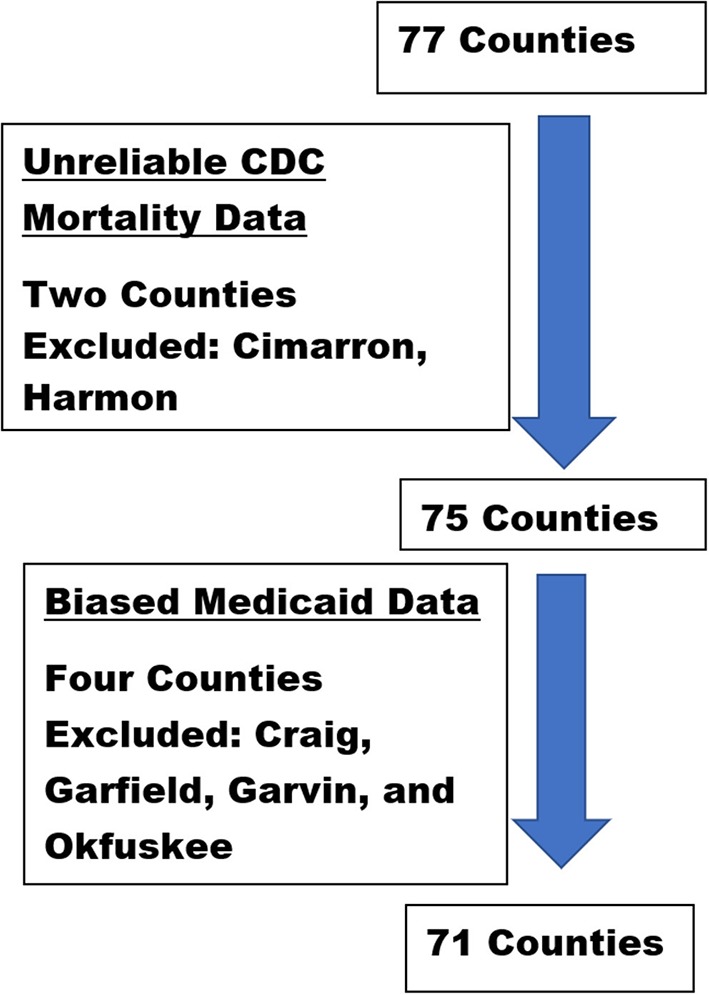
Oklahoma county-level male dataset selection process and rationale.